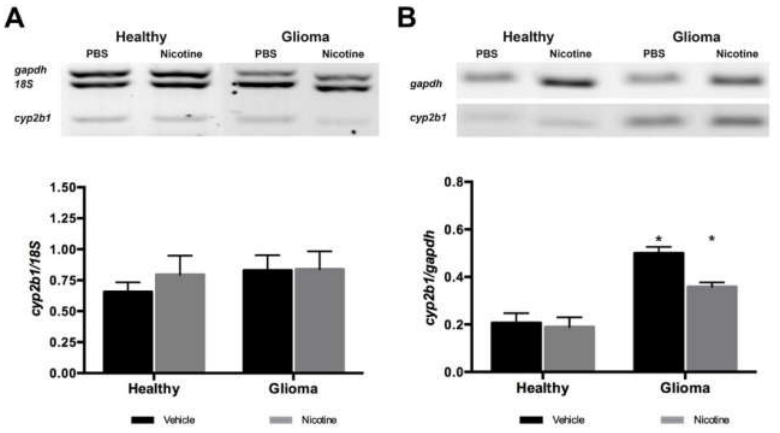
Figure 2. Effect of nicotine on Cyp2b1 mRNA levels in the liver and brain. Cyp2b1 mRNA levels were analyzed by multiplex RT-PCR. ( A ) Representative RT-PCR multiplex for Cyp2b1 detection in liver tissue. Nicotine treatment did not modify Cyp2b1 mRNA in the liver of healthy rats or animals with glioma. ( B ) Representative RT-PCR multiplex for Cyp2b1 detection in brain tissue. Glioma brain tissue expressed higher levels of Cyp2b1 mRNA compared to normal brain tissue and nicotine treatment do not change the Cyp2b1 gene expression (* p < 0.05 vs. healthy vehicle). Data represent the means ± SE. 18S and Gapdh were used as reference controls.